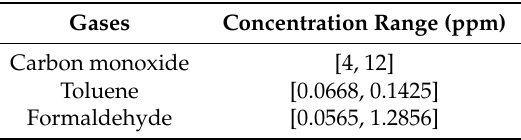
Table 1. Concentration of the target gases.